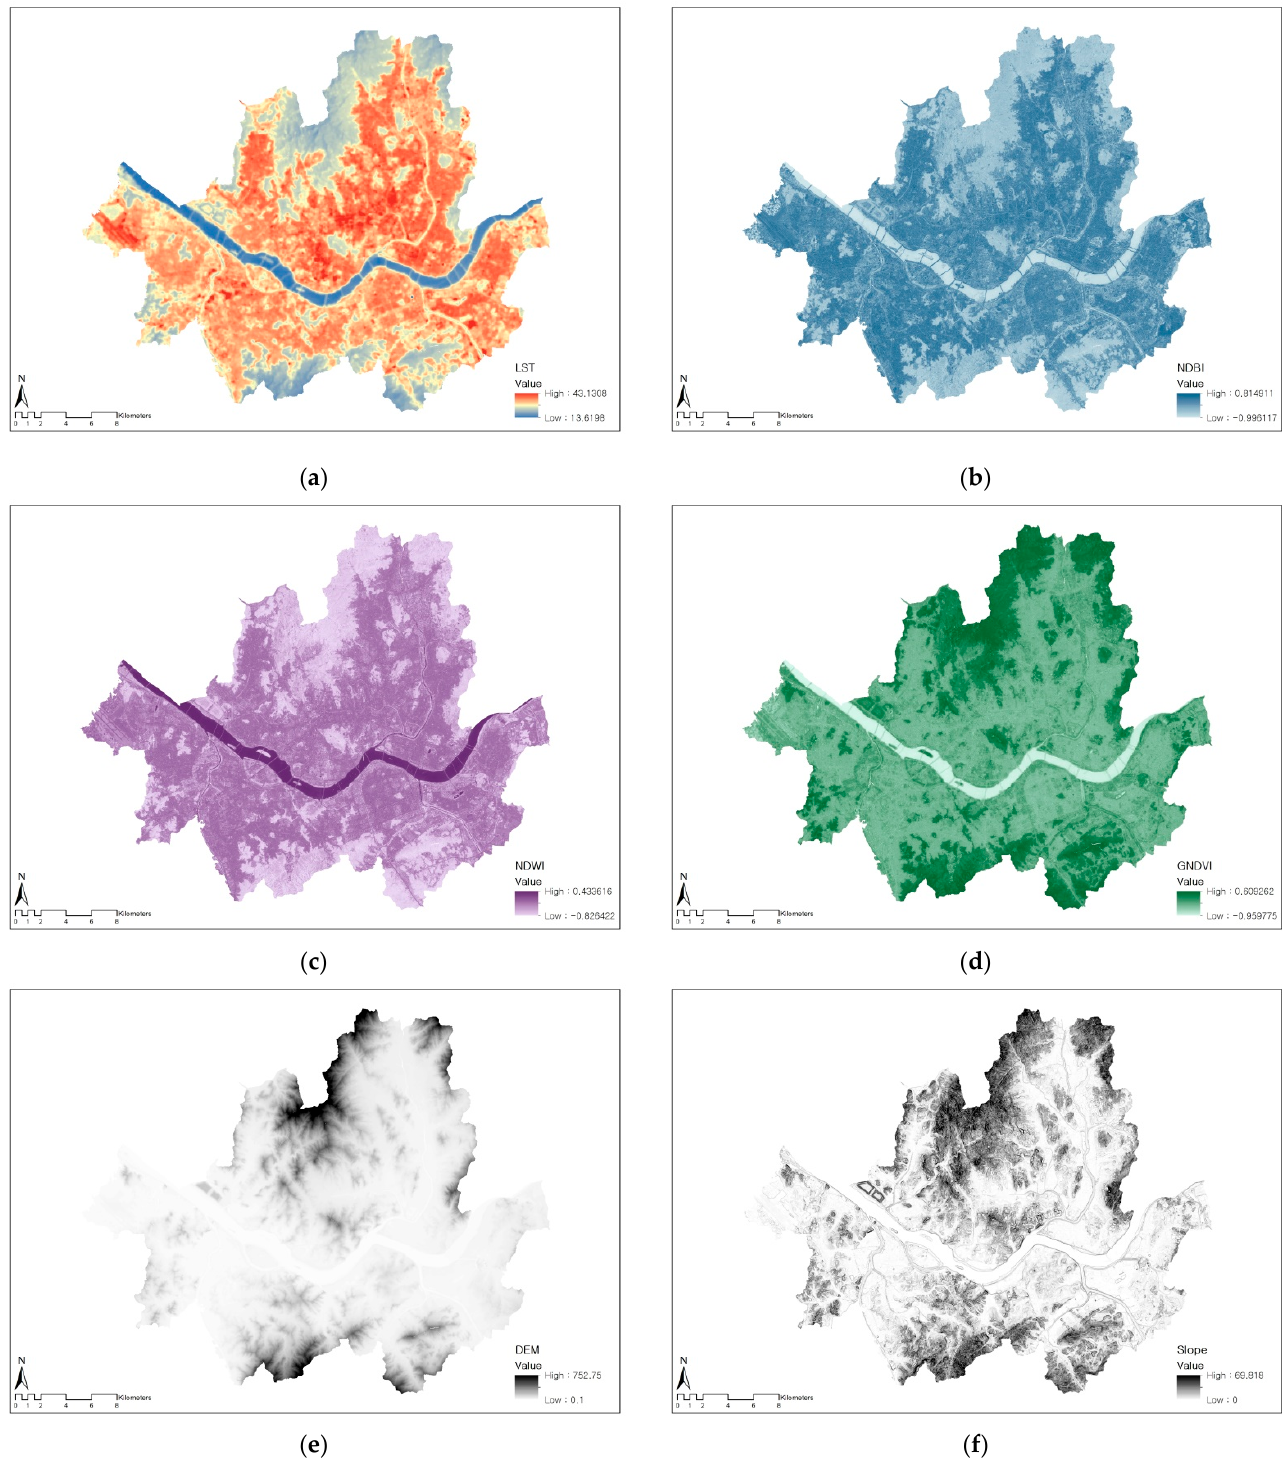
Figure 2. Variables used in the study. ( a ) LST, ( b ) NDBI, ( c ) NDWI, ( d ) GNDVI, ( e ) elevation, ( f ) slope.